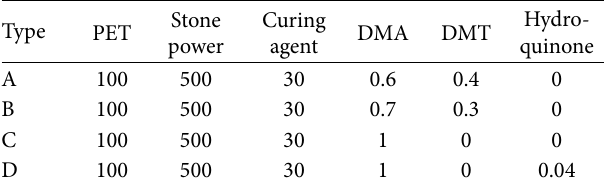
Figure 5: Gel time test device for resin anchorage agent. (a) The photo of blast drying oven after transformation, (b) soft insulation door sectional view, (c) electronic balance, and (d) anchoring agent gel time test sample. Table 4: Proportion table of resin anchorage cement.